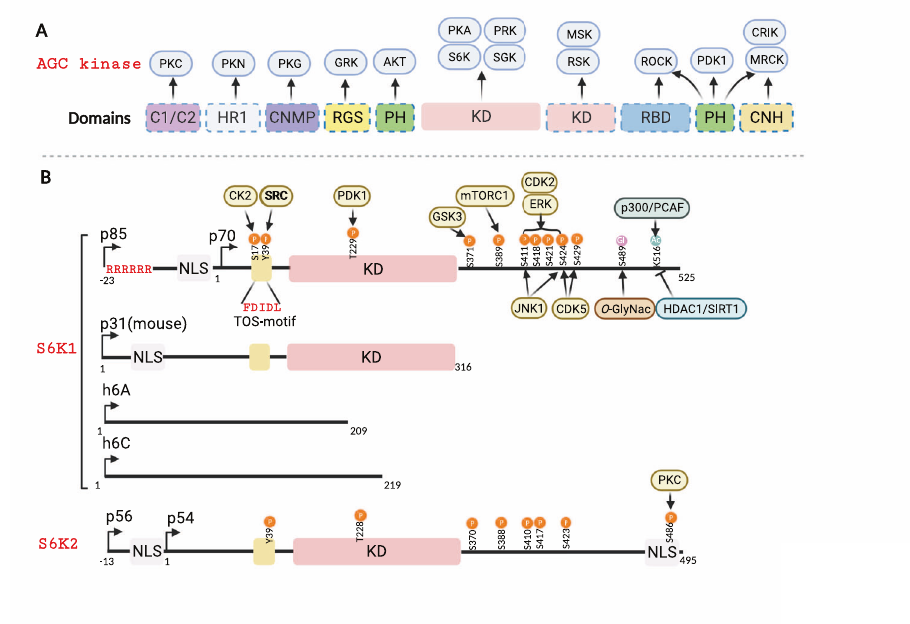
Fig. 1 Protein structure and functional domains for S6Ks. A Conserved features of AGC family kinases. AGC family kinases are divided into 21 subfamilies due to the conserved functional regions beyond the kinase domain. B Alternative translation start sites of S6K result in several isoforms of S6K proteins. S6K1/2 share more than 80% similarity in their amino acid sequences, so they are often subject to similar posttranslational modi fi cations (PTMs) but also with observed differences among isoforms. C1/C2, conserved domain 1 or 2; HR1, heptapetide repeat 1; CNMP, cyclic nucleotide monophosphate-binding; RGS, regulator of G protein signaling; PH, pleckstrin homology; KD, kinase domain; RBD, Rho-binding domain; CNH, citron homology; P, Gl, and Ac represent phosphorylation, glycosylation, and acetylation,